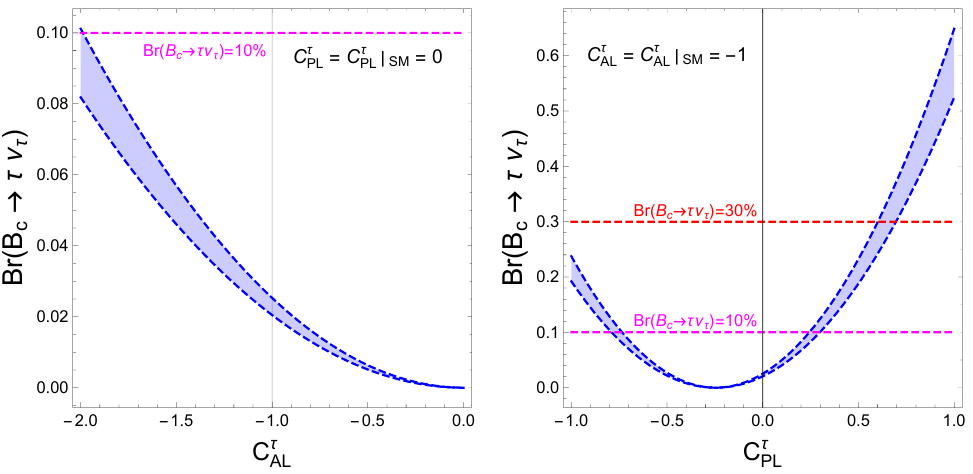
and C (cid:28) . The upper bounds, 30% and 10% on AL PL